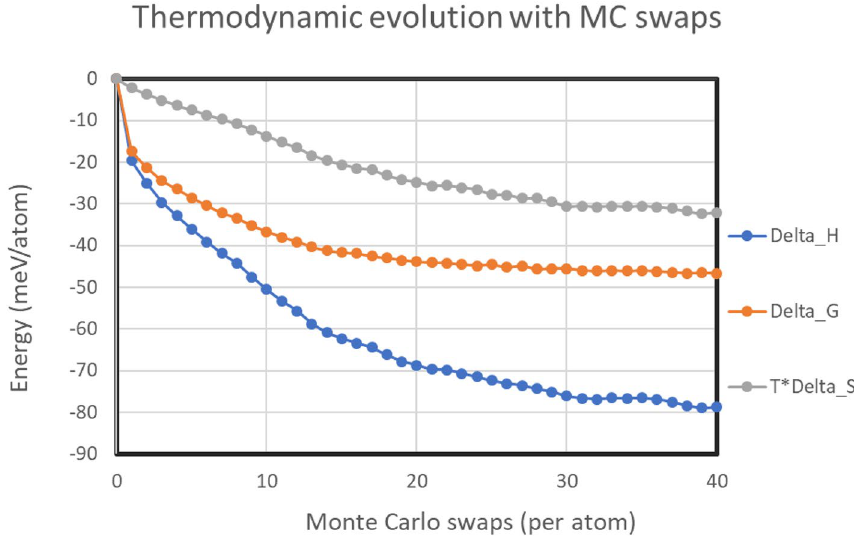
Figure 1. Change in enthalpy, Gibbs free energy and entropic contributions with the MC/MD structure evolution at 1800